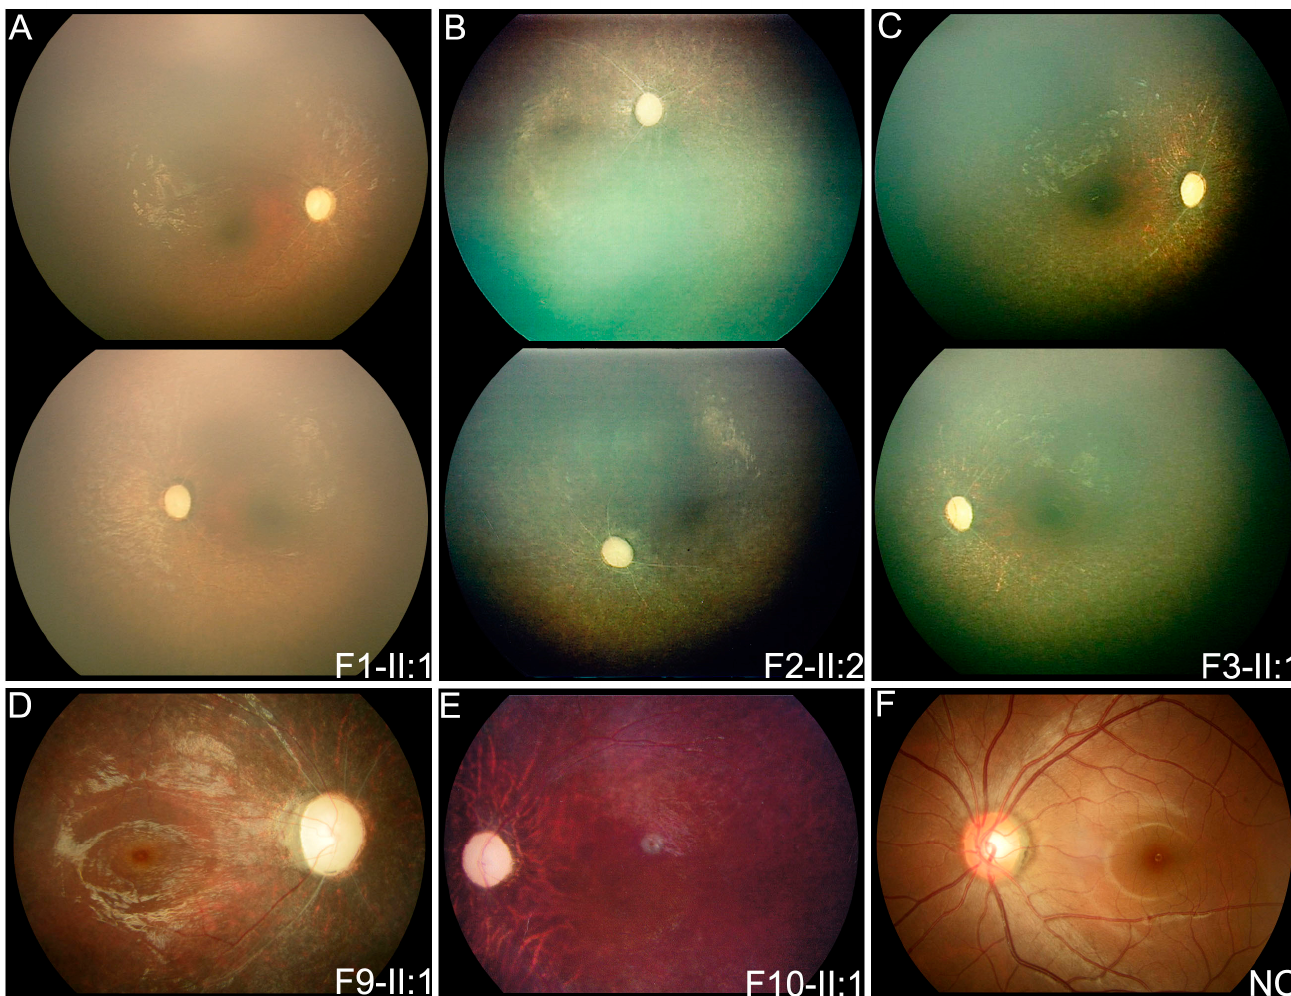
Figure 2. Posterior fundus photographs of three patients with congenital severe retinopathy resem- bling LCA, two patients with EOSRD, and one normal control. Complete optic disc pallor, silver wiring of retinal vessels, and generalized salt-and-pepper retinal degeneration were observed in RetCam imaging of patient F1-II:1 ( A ), patient F2-II:2 ( B ), patient F3-II:1 ( C ), and in color fundus photograph of patient F9-II:1 ( D ). In patient F10-II:1 ( E ), complete optic disc pallor, severe a tt enua- tion of retinal vessels, and tapetoretinal degeneration was observed in color fundus photographs. ( F ) Fundus photograph of a normal control. LCA, Leber congenital amaurosis; EOSRD, early-onset retinal dystrophy; NC, normal control. Table 2. Clinical information of the eight patients with biallelic FDXR variants.